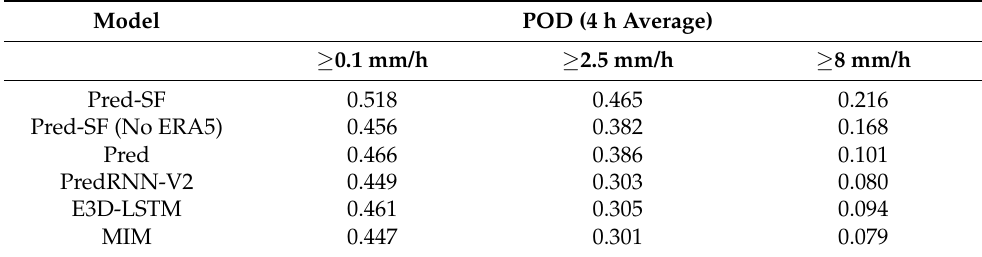
Table 3. POD indicators of three groups of different